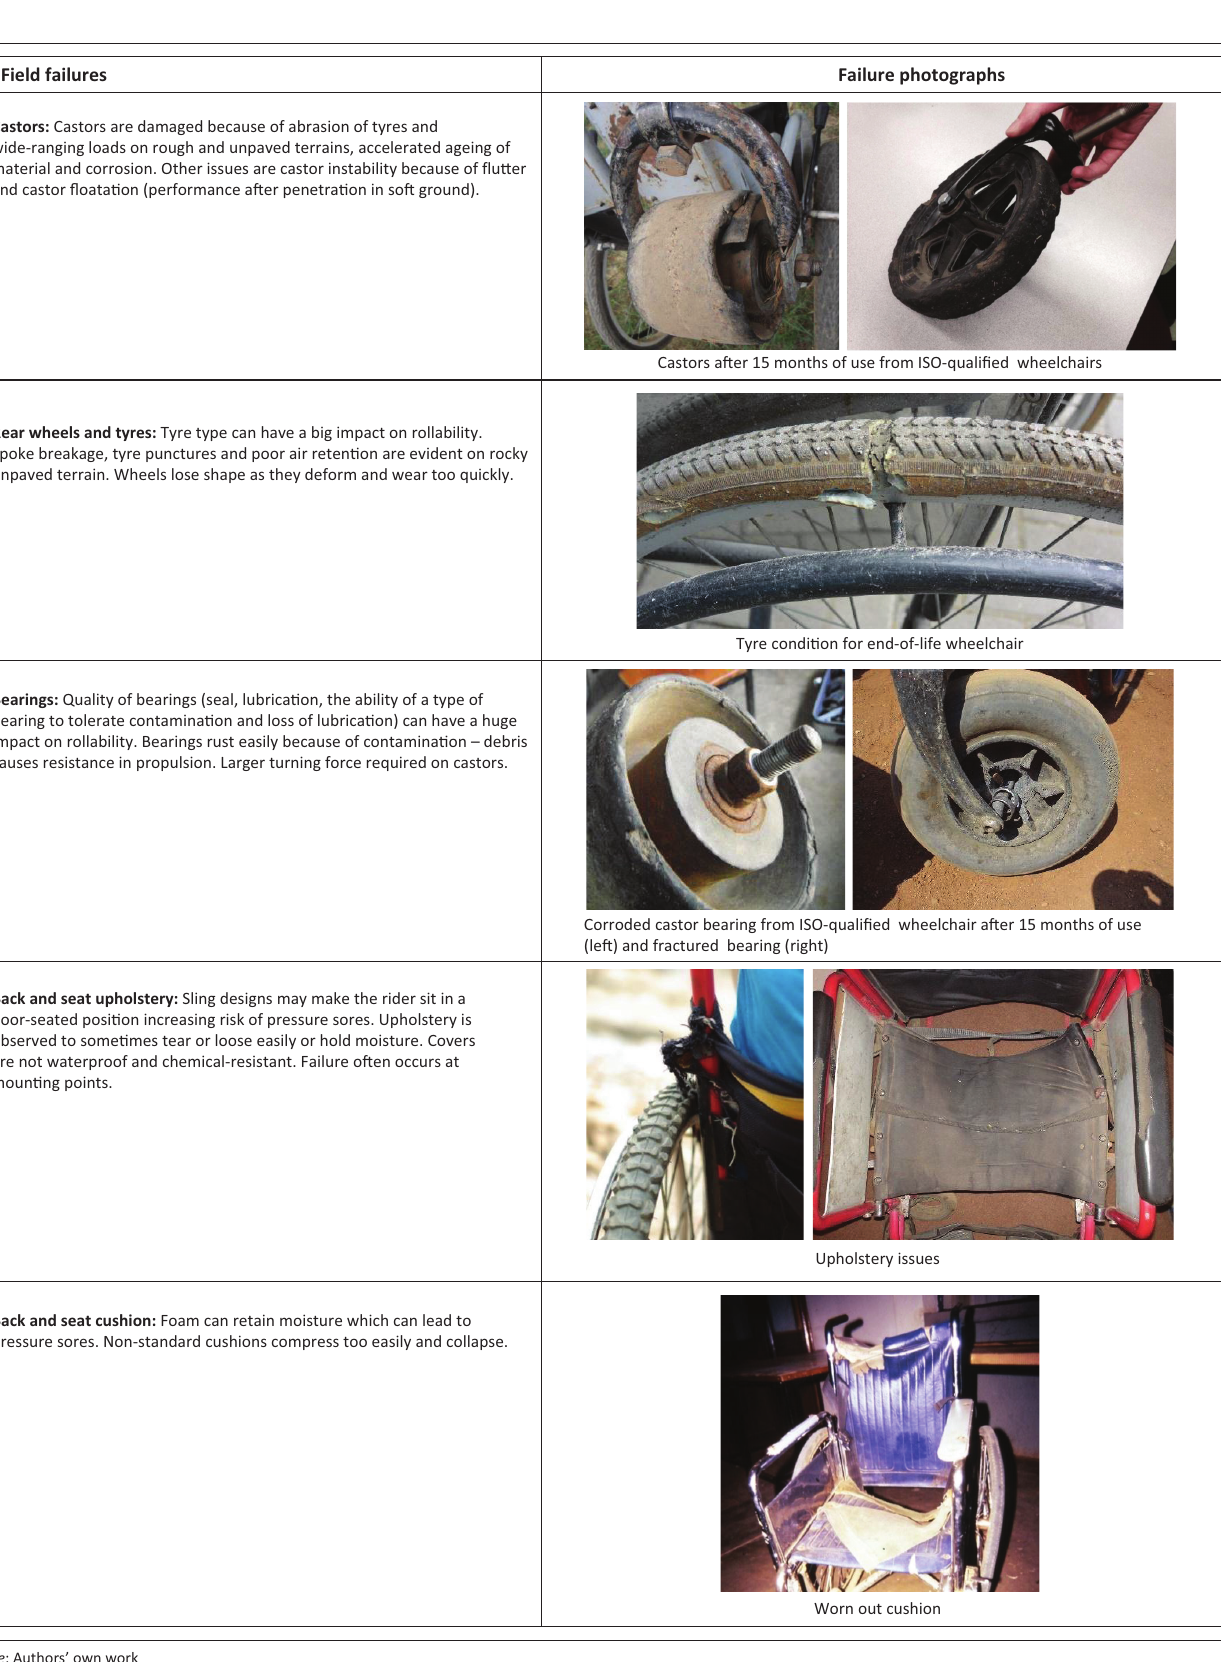
FIGURE 6: Failures noted by International Society of Wheelchair Professionals Standards Working Group experts on wheelchairs designed for less-resourced environment use.